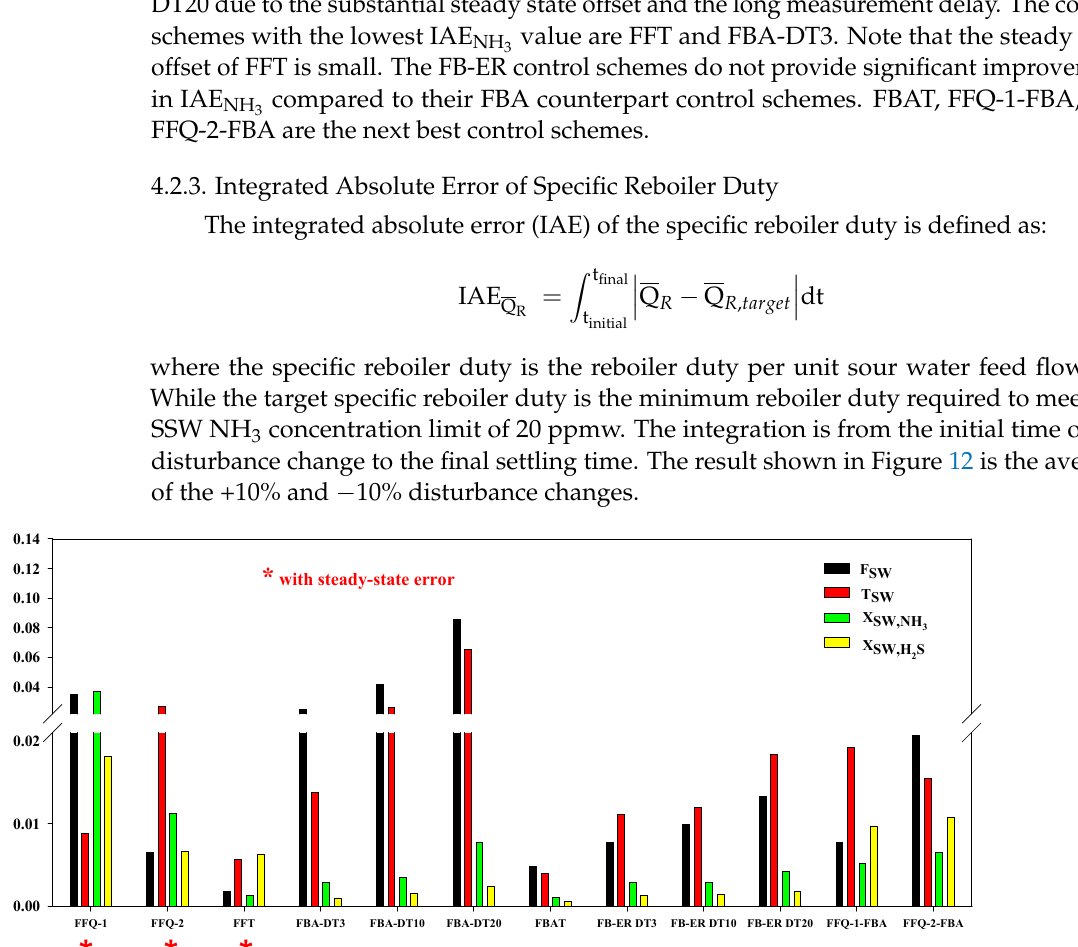
Figure 11. Integrated absolute error (IAE) of NH 3 concentration results of all control schemes for the sour water feed stream disturbances, including flowrate, temperature, NH 3 concentration, and H 2 S concentration. (* with steady state off- set).